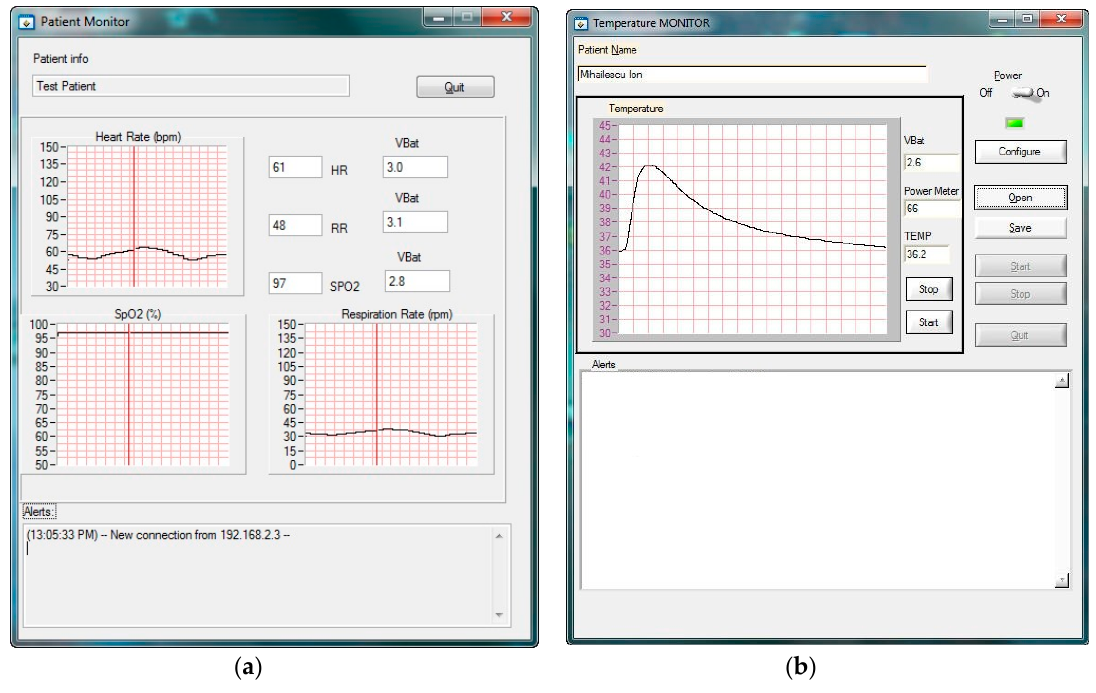
Figure 11. Graphical interface running on the patient’s device used for telemonitoring: ( a ) heart rate, blood oxygen saturation (SpO 2 ), and respiration rate [38]; ( b ) body temperature.